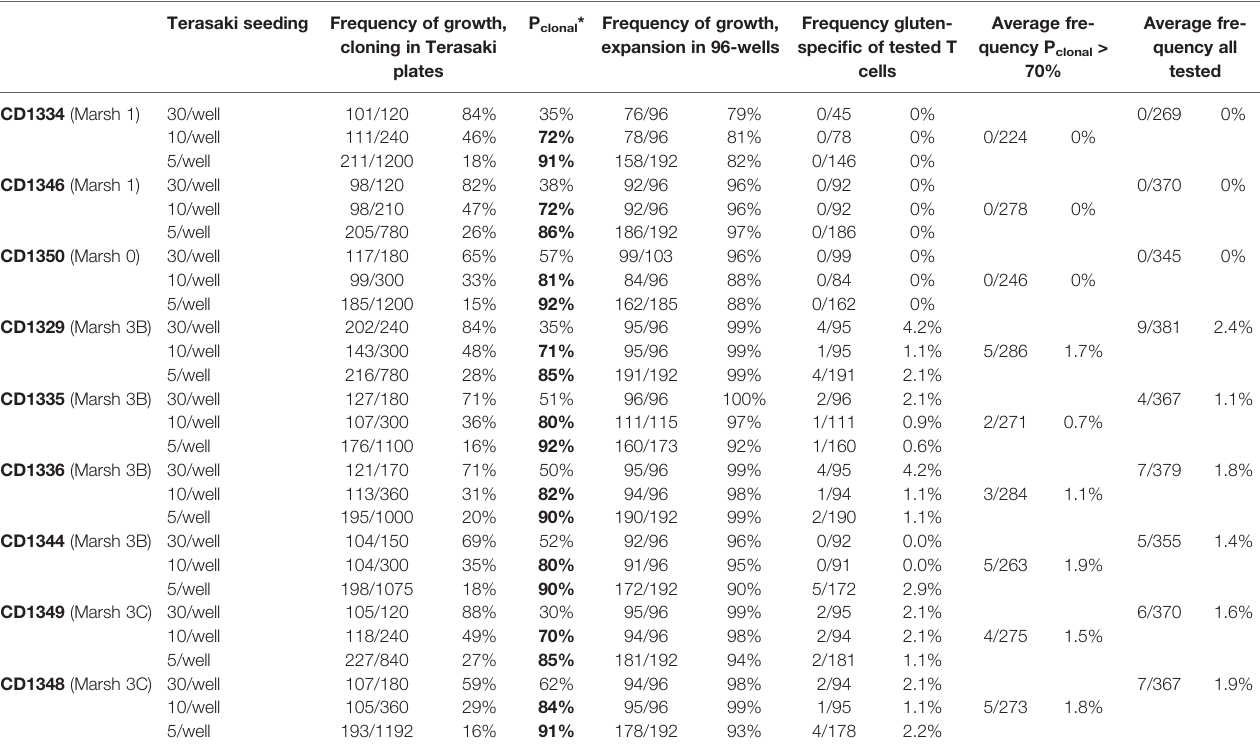
TABLE 2 | Detailed cloning frequency. Terasaki seeding Frequency of growth,